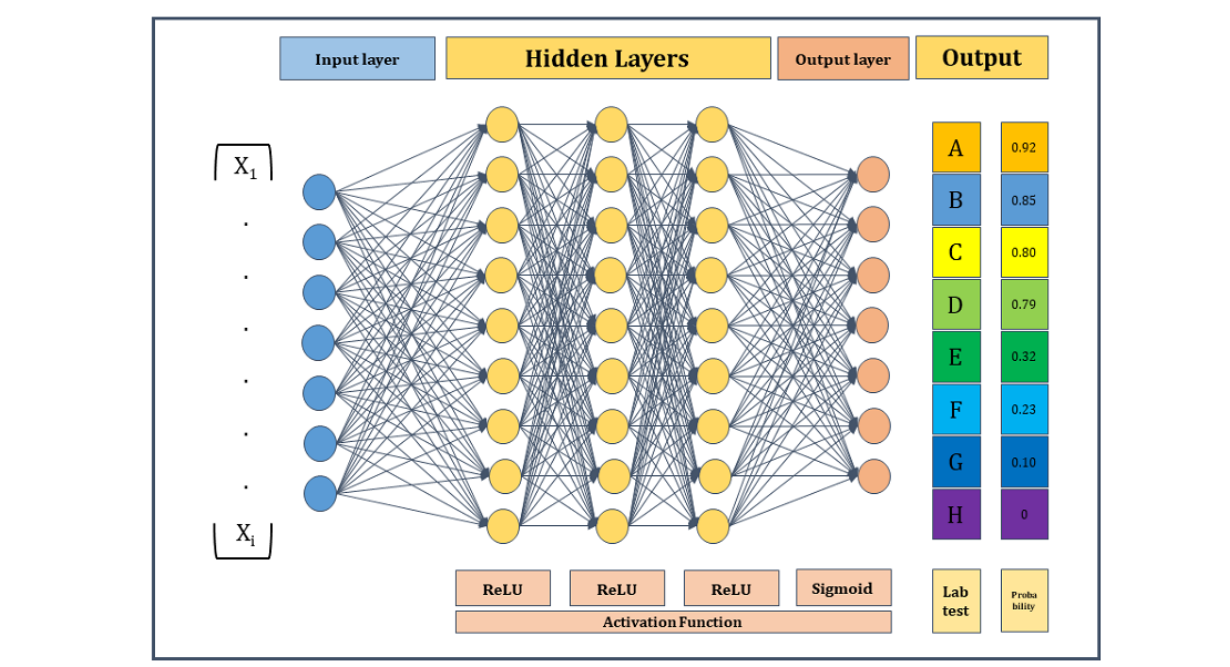
Figure 2. An architecture of proposed deep learning